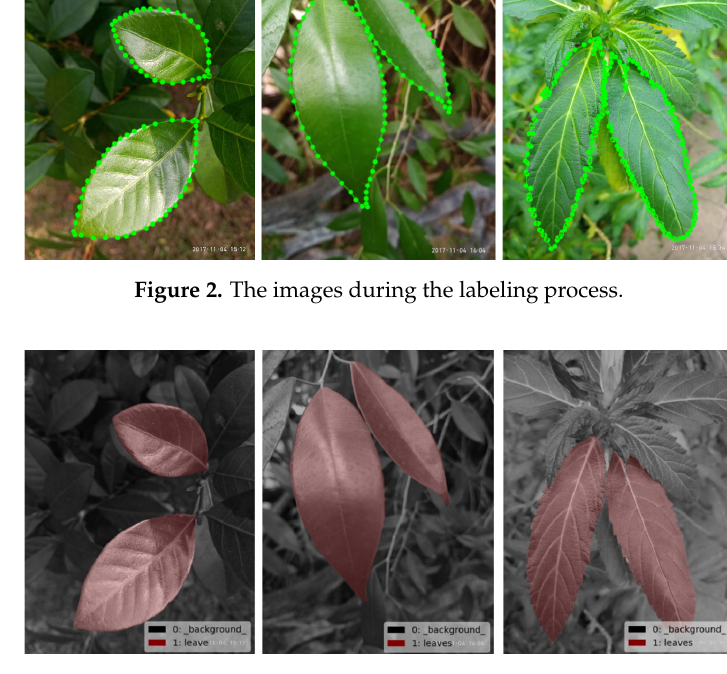
Figure 3. The labeled